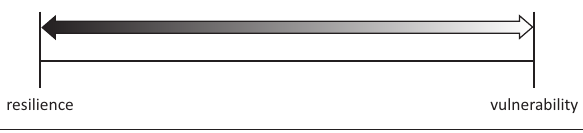
FIGURE 3: Resilience and vulnerability as opposite ends of a